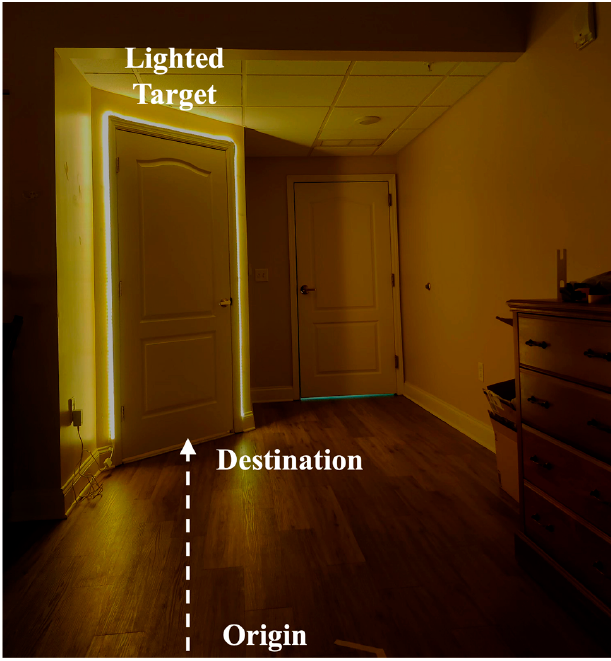
Figure 1. A conceptual illustration (rather than an exact replication due to participation privacy concerns) of the salient target by installing the LED strip in a dark environment. During the experiment, participants were instructed to walk from the designated origin (i.e., near their beds) to the destination (i.e., near the bathroom entrance), with the lighting target turned on or off around the destination of the walking trials (Figure